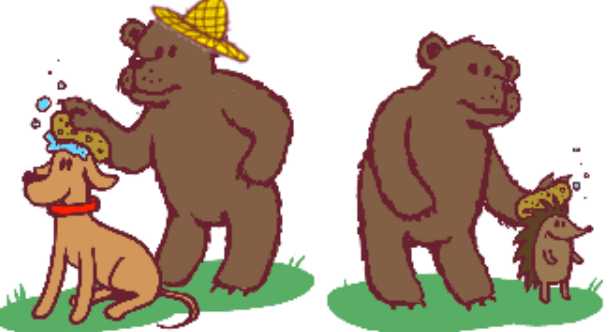
Figure 3. Picture paired with test item (6).